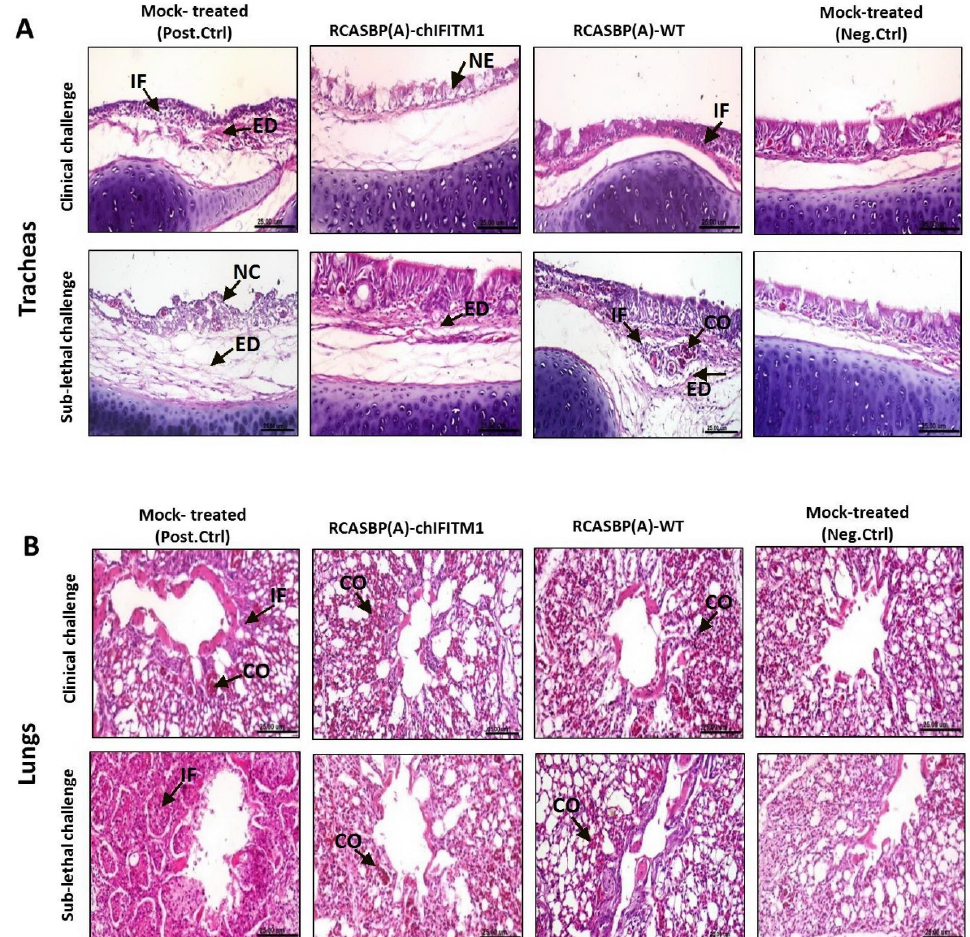
Figure 5. Photomicrographs representing H & E-stained sections of tracheas ( A ) and lungs ( B ) collected from RCASBP(A)- chIFITM1 and RCASBP(A)-WT challenged chicks with clinical and sub-lethal doses of H5N1 HPAIV compared to mock inoculated chicks (negative and positive control groups); showing edema (ED), focal necrosis (NE), inflammatory cells infiltration (IF), congestion (CO) (scale bar 25 μ m).